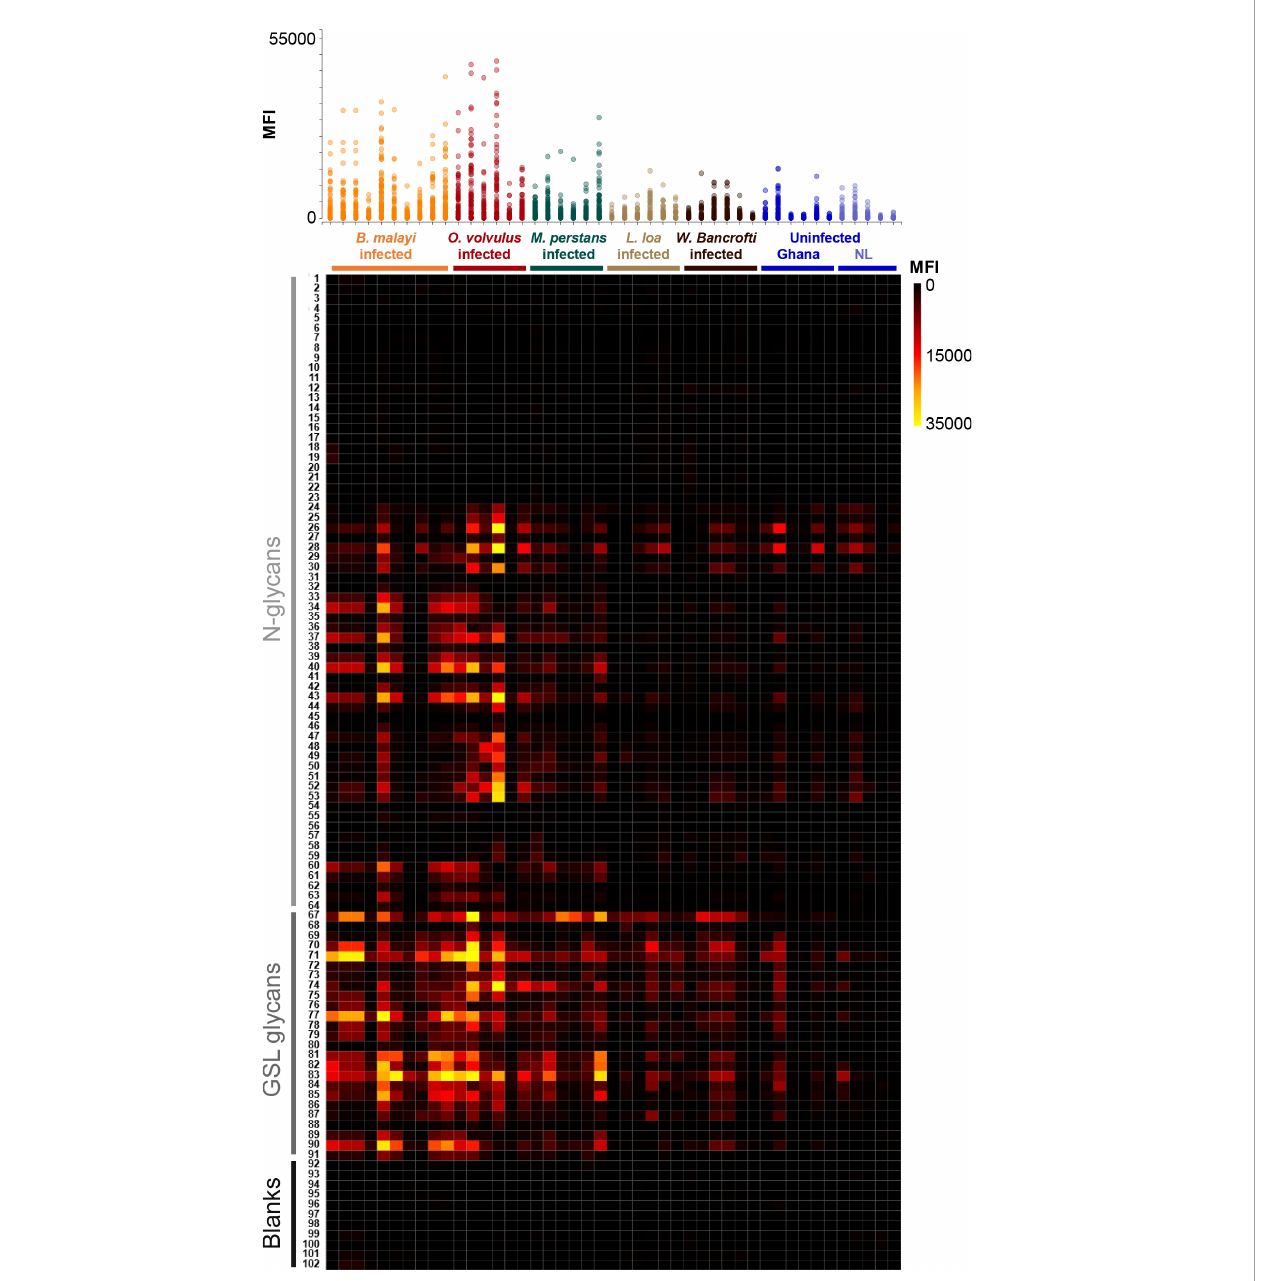
FIGURE 1 IgG responses to B. malayi N-linked and GSL glycans in plasma from various fi larial-infected and uninfected individuals. B. malayi glycan microarrays were screened with plasma from individuals infected with B. malayi (n = 10), O. volvulus (n = 6), M. perstans (n = 6), L. loa (n = 6), W. bancrofti (n = 6) and with plasma from uninfected individuals from Africa (Ghana, n = 6) and Europe (The Netherlands, NL, n = 5). Background corrected median fl uorescence intensities (MFIs) resulting from IgG binding are shown on the upper graph for each donor (X-axis). Each spot on the Y-axis corresponds to a different glycan fraction or blank spot. The heatmap generated from these data allows the visualization of IgG from each donor (X-axis) to each array fraction (Y-axis) indicated by their ID numbers (21). The type of glycan in the fractions is indicated on the left: N-glycans, GSL glycans or Blanks (negative controls, no glycan). Raw data can be found in Table